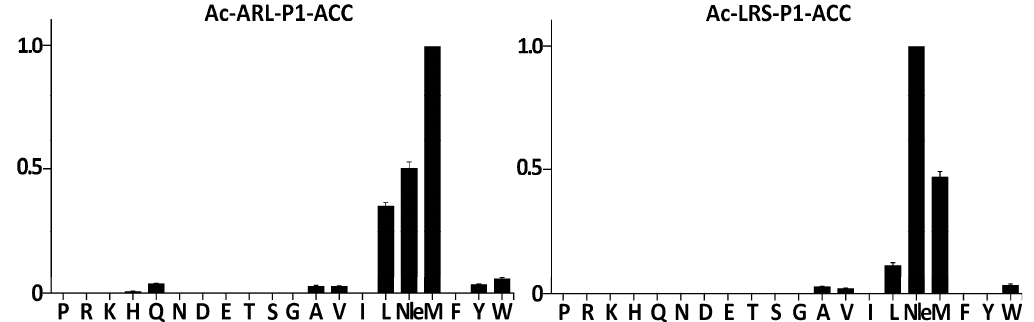
Figure 1. Substrate specificity of SplF protease at the P1 subsite. Substrate preference of SplF at the P1 subsite was determined using two fluorogenic substrate libraries: Ac ‐ Ala ‐ Arg ‐ Leu ‐ P1 ‐ ACC and Ac ‐ Leu ‐ Arg ‐ Ser ‐ P1 ‐ ACC. Vertical bars indicate the activity of the enzyme against each tested sublibrary normalized to the most active sublibrary. Residues fixed at the P1 subsite are indicated with the single ‐ letter amino acid code.